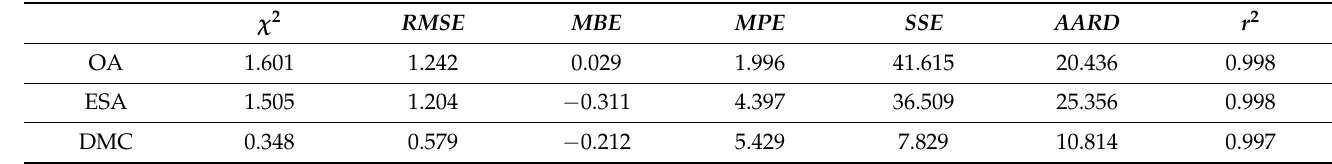
Table 7. The “goodness of fit” tests for the developed ANN model.